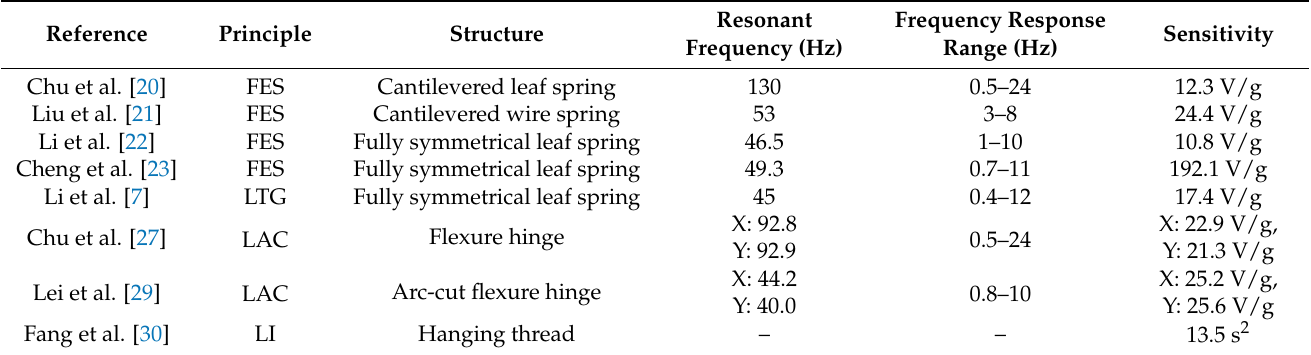
Table 1. Parameters of the accelerometer based on optical path